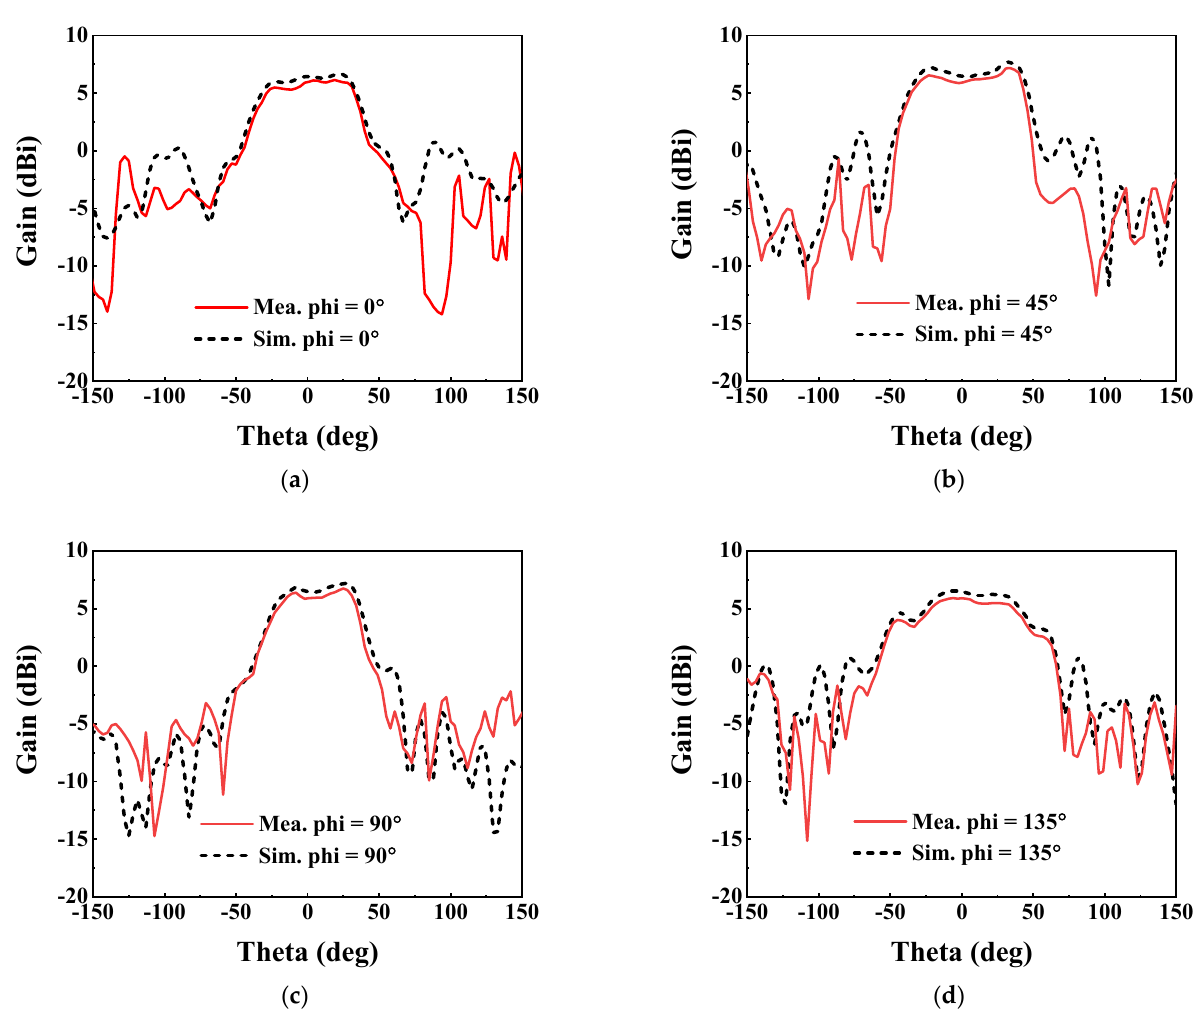
Figure 9. Measured and simulated gain results of the proposed antenna in different cut − planes of ( a ) phi = 0 ◦ , ( b ) phi = 45 ◦ , ( c ) phi = 90 ◦ , and ( d ) phi = 135 ◦